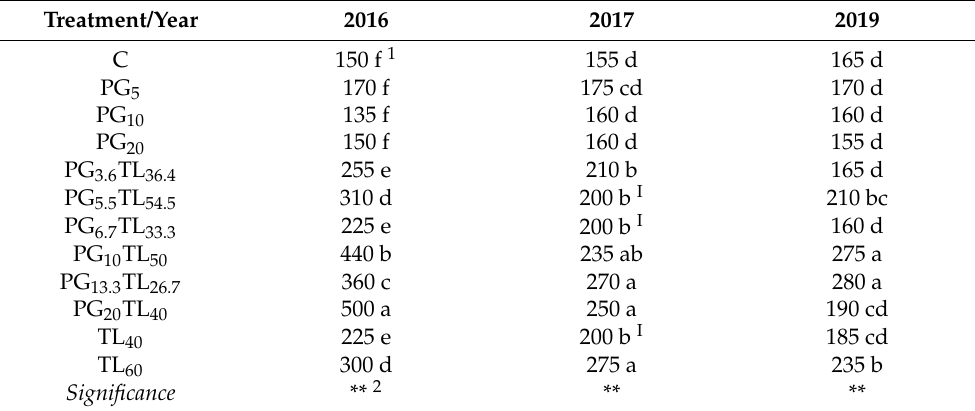
Table 14. Effect of treatments and years on the content of exchangeable potassium (K ex , mg kg –1 ) at 0–20 cm soil layer.